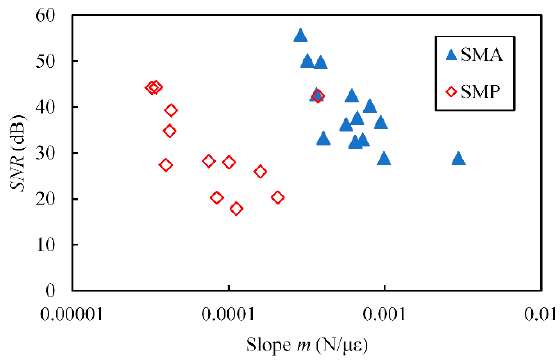
Figure 15. Relationship between slope m and SNR .